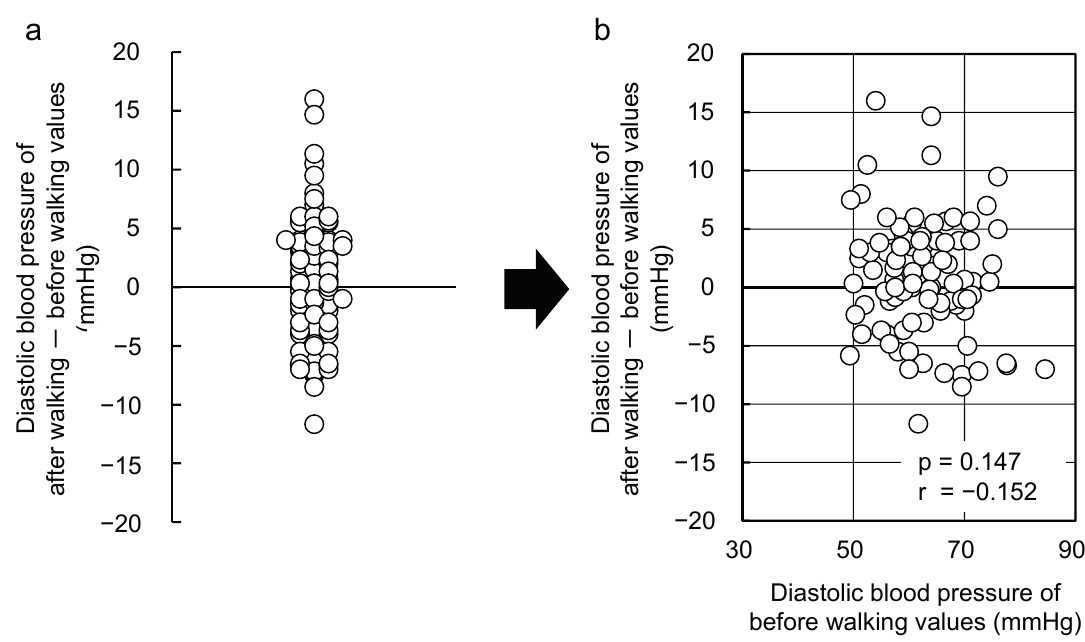
Figure 2. Changes observed with respect walking in a forested area. Individual differences ( a ) and the relationship between the “initial value” and the “changes after walking in a forested area” ( b ) with respect to diastolic blood pressure (n = 92). ** p < 0.01 by Pearson correlation test.